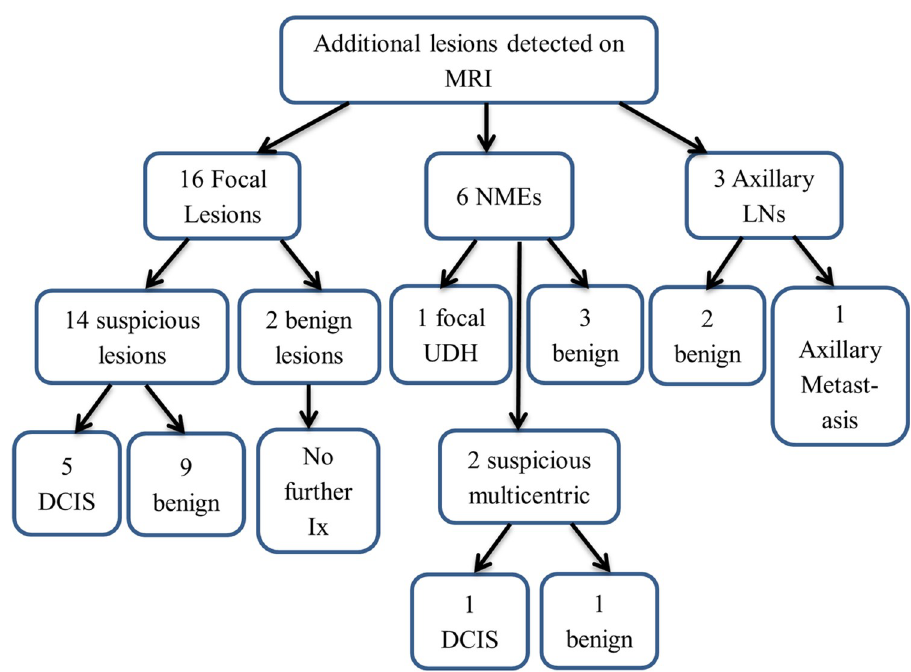
Fig 2. Additional lesions detected on MRI. NME = Non-mass enhancement, LNs = Lymph nodes, UDH = Usual ductal hyperplasia, DCIS = Ductal carcinoma in-situ, Ix = Investigation.